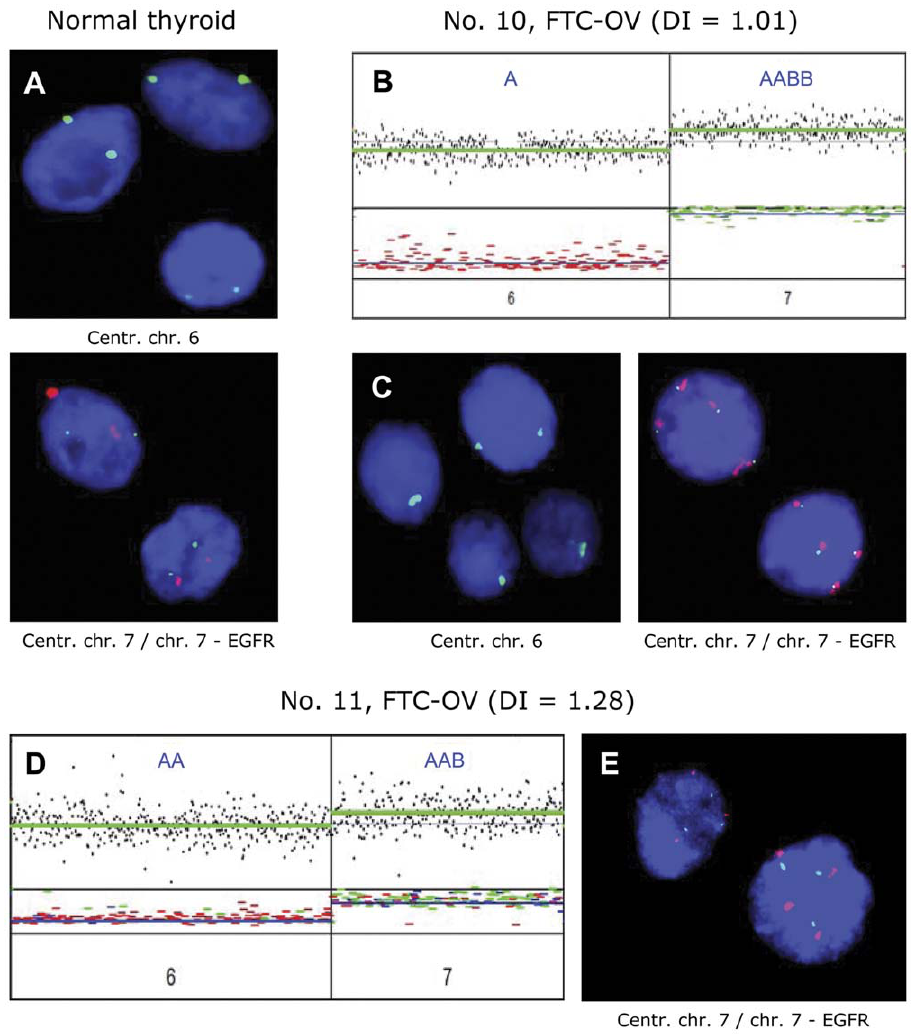
Figure 4. Interphase FISH analysis in relation to allelic state analysis. In FTC-OV, chromosome 6 was always observed in allelic state [A] or [AA], whereas chromosome 7 was always retained in a heterozygous state or amplified heterozygous state. To confirm these results, interphase FISH was performed for chromosomes 6 and 7. Examples are shown, see also Table 1. A . FISH on normal thyroid epithelium. B and C show FTC-OV case No. 10. B : Allelic state analysis illustrating allelic state [A] for chromosome 6 and allelic state [AABB] for chromosome 7. C . Left panel: green signal, centromere 6 shows 1 copy, confirming the allelic state [A] in three of the four nuclei. Right panel: four green and four red signals representing EGFR and centromere 7, respectively and confirming the [AABB] allelic state. D–E show FTC-OV, case no 11. D . The allelic state [AAB] of chromosome 7 could not be confirmed definitively and showed a mixture of nuclei containing three green (EGFR) and three red (centromere) signals or four green and four red signals, respectively ( E ). This may be due to intra-tumour